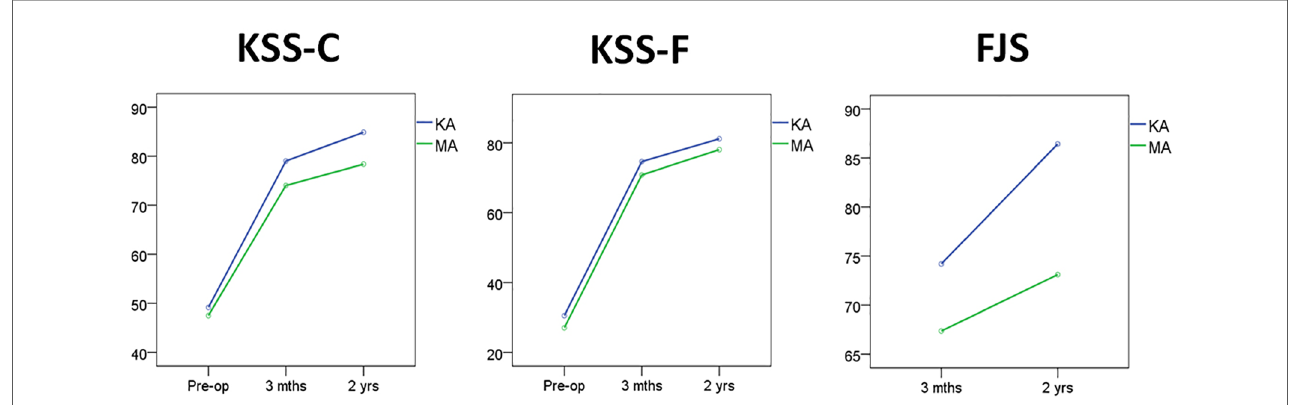
FIGURE 4 The trends of KSS-C, KSS-F and FJS before and after surgery. KA, kinematic alignment; MA, mechanical alignment; KSS-C, knee joint clinical score; KSS-F, knee joint functional score; FJS, forgotten joint score.